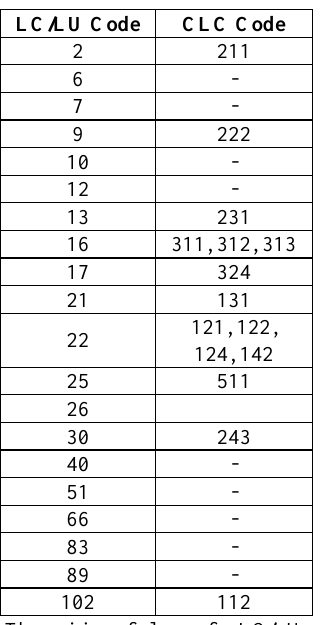
Table 3 . The pairing of classes for LC/LU and CLC